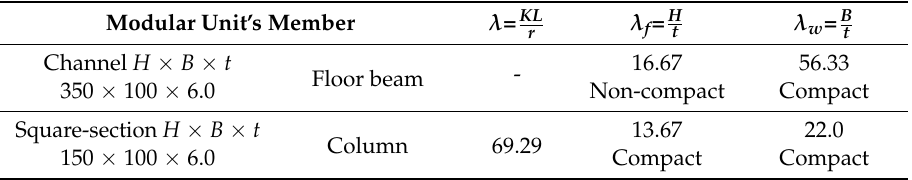
Table 2. Slenderness ratio and width-to-thickness ratio of the modular unit’s elements.